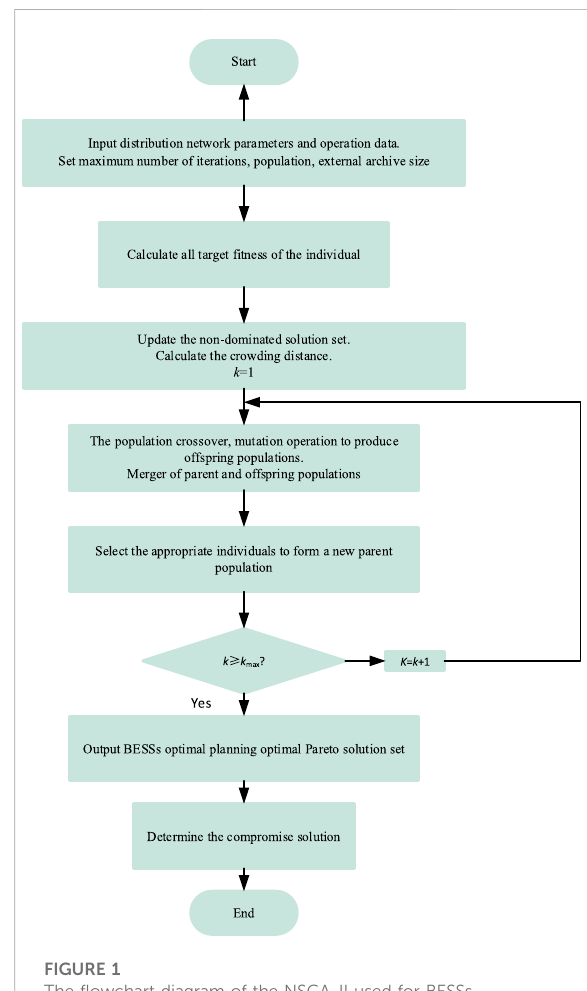
FIGURE 1 The fl owchart diagram of the NSGA-II used for